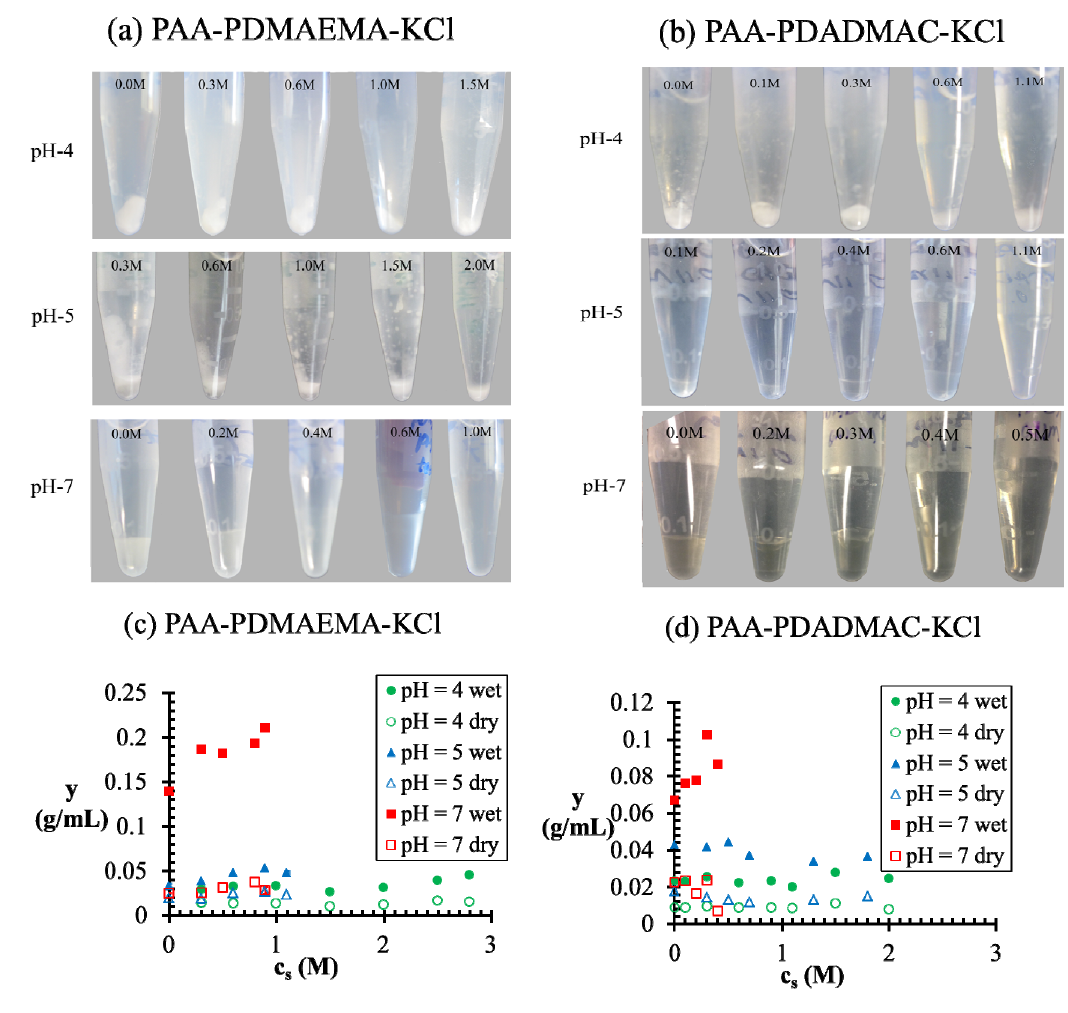
Figure 6. Pictures of vials containing polyelectrolyte complexes for different pH and KCl -PDMAEMA -KCl and ( b ) PAA -PDADMAC -KCl at concentrations for ( a ) PAA 597 526 597 557 salt concentrations indicated on the vials. The maximum salt concentration for each set of pictures is close to the critical salt concentration for that pH. The experimental yield ( (cid:1877) ) is defined as the weight of wet/dry dense phase divided by the total wet volume of both phases for the ( c ) PAA -PDMAEMA -KCl and ( d ) PAA -PDADMAC -KCl, as a 597 526 597 557 function of salt concentration for different pH